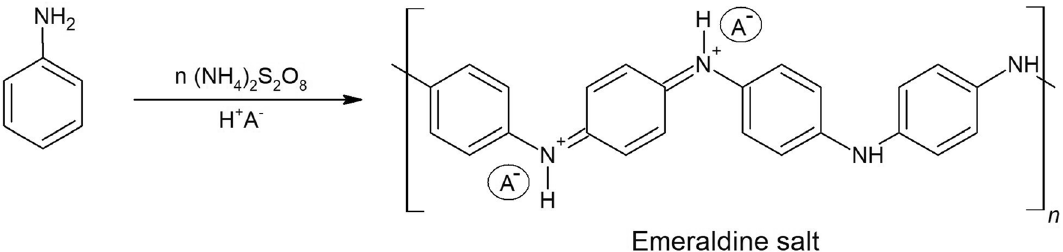
Figure 1. Oxidative polymerization of aniline using ammonium persulfate as an oxidant.